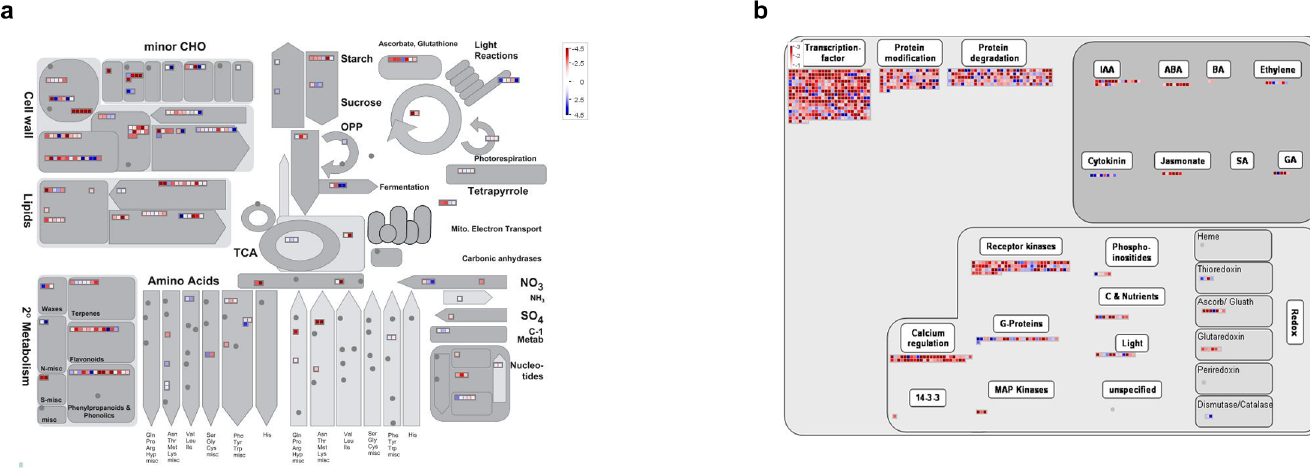
Fig 8. MapMan overview of cellular metabolism (a) and regulation (b)in OVR1-vs-OVR4.Each square represented a gene, and the color key represented the value of RPKM normalized log 2 . Red meant down-regulation of the gene and the blue color meant